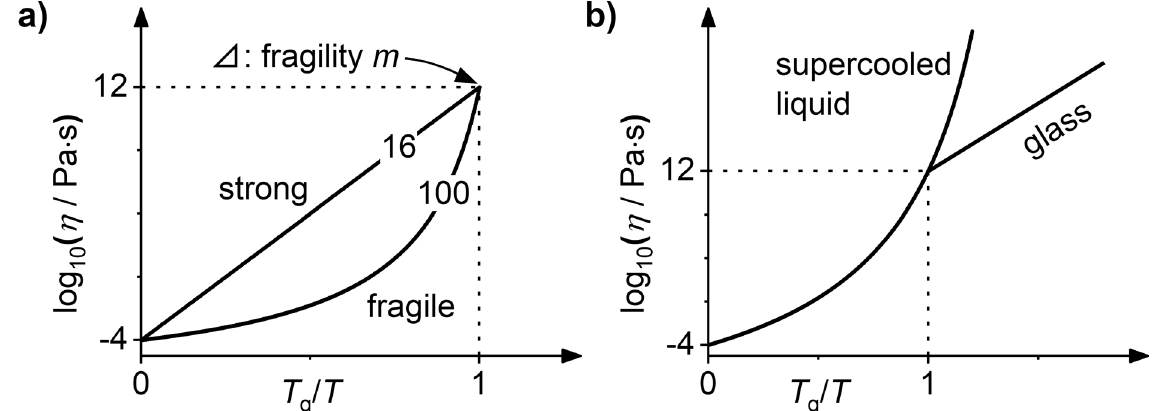
Fig. 1 Viscosity-temperature dependence in liquids and glasses. In Angell plots, T g / T is the inverse temperature scaled by the glass transition temperature T g 6 – 9 . By rheological convention, T g corresponds to a viscosity of 10 12 Pa·s, around which the calorimetric glass transition commonly occurs 6,11 . a Liquid fragility: In the strong limit, liquids exhibit a linear temperature dependence according to the Arrhenius Equation η ¼ η exclusively from thermal activation and entails no structural changes, so the underlying fl ow mechanism and activation energy E A remain unchanged 1,7,8 . By comparison, fragile liquids exhibit lower viscosities throughout, and a steep increase upon approaching T g resulting from large structural changes 1,2,7,8,50 . Speci fi cally, with decreasing temperature fl ow requires increasingly cooperative rearrangement, leading to growing activation barriers. The fragility parameter m is the slope at T g . It ranges from 16 for Arrhenius behavior, most closely realized by SiO 2 6 , and exceeds 100 for fragile liquids 6,7 . b Glass transition: The supercooled liquid in metastable equilibrium can continuously adjust its structure to temperature changes. This is the origin of fragile, non-Arrhenius behavior. By contrast, the liquid falls from equilibrium into the glass state at T g . Here, the time scale for structural changes becomes larger than the experimental time scale 1,8,37 . This frozen-in isostructural glass con fi guration exhibits a shallow viscosity – temperature dependence governed by Arrhenius-type thermal activation 1,20,37 . (For simplicity, identical T g and fi ctive temperature are assumed